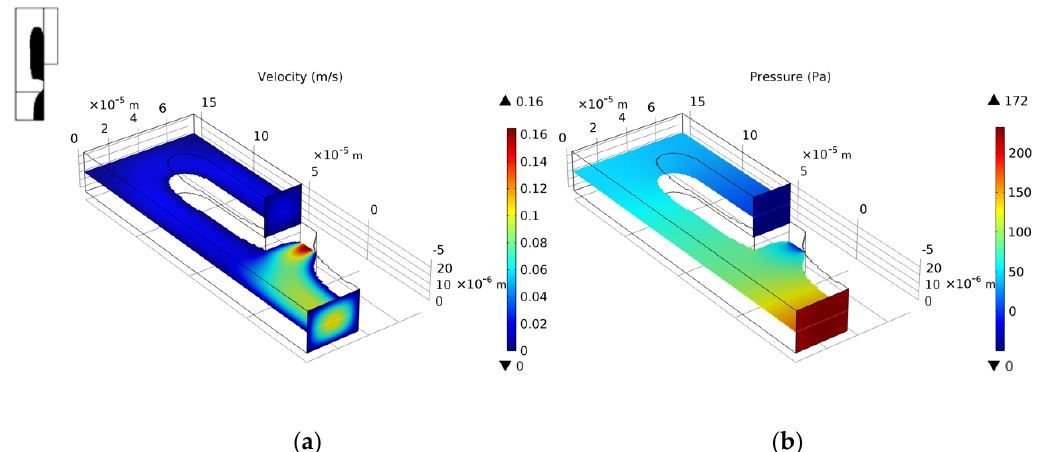
Figure 6. ( a ) The velocity field distribution and ( b ) pressure field distribution of 3D model without captured cell.